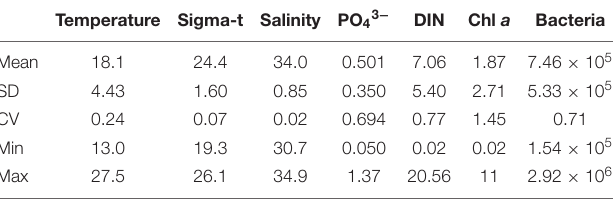
TABLE 1 | Summary of the means and variability in temperature ( ◦ C), sigma-t, salinity, PO 43 − ( µ M), dissolved inorganic nitrogen (DIN, µ M), bacterial abundance (cells mL − 1 ), and Chl a concentration ( µ g L − 1 ); n is 53 (salinity and sigma-t), 54 (temperature), or 56 (other variables).